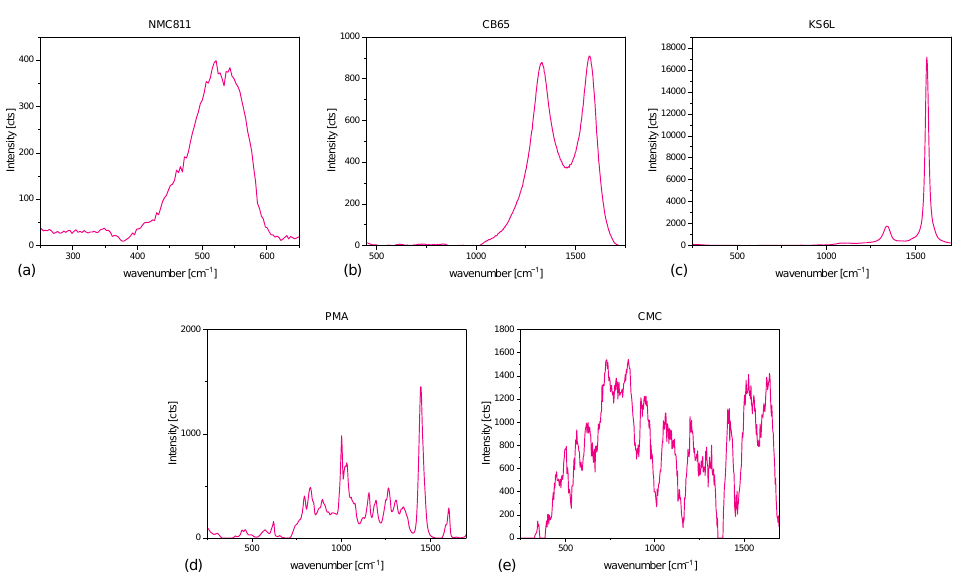
Figure A1. Raman spectra of all materials used for slurry mixing ( a ) NMC811, ( b ) KS6L, ( c ) CB65, ( d ) PMA, ( e )